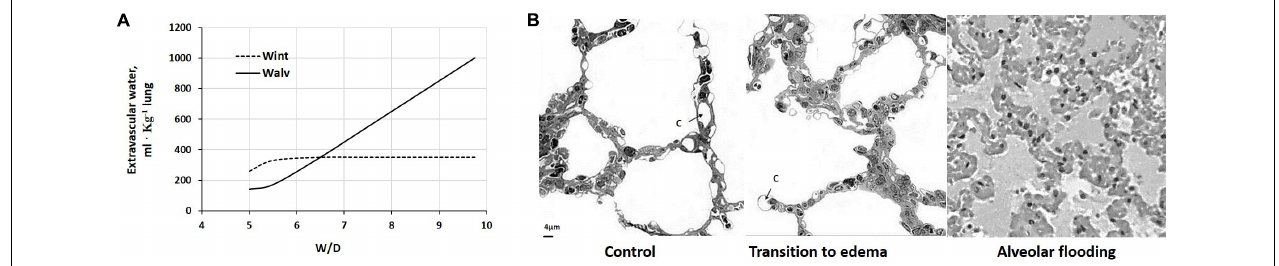
FIGURE 7 | (A) Distribution of extravascular lung water to the interstitial (Wint) and alveolar (Walv) compartment on increasing W/D. (B) Morphological changes of the lung from control (left) to a transition phase with fluid accumulation in the interstitial space (center) and alveolar flooding (right). c, pulmonary capillary (redrawn from Miserocchi,